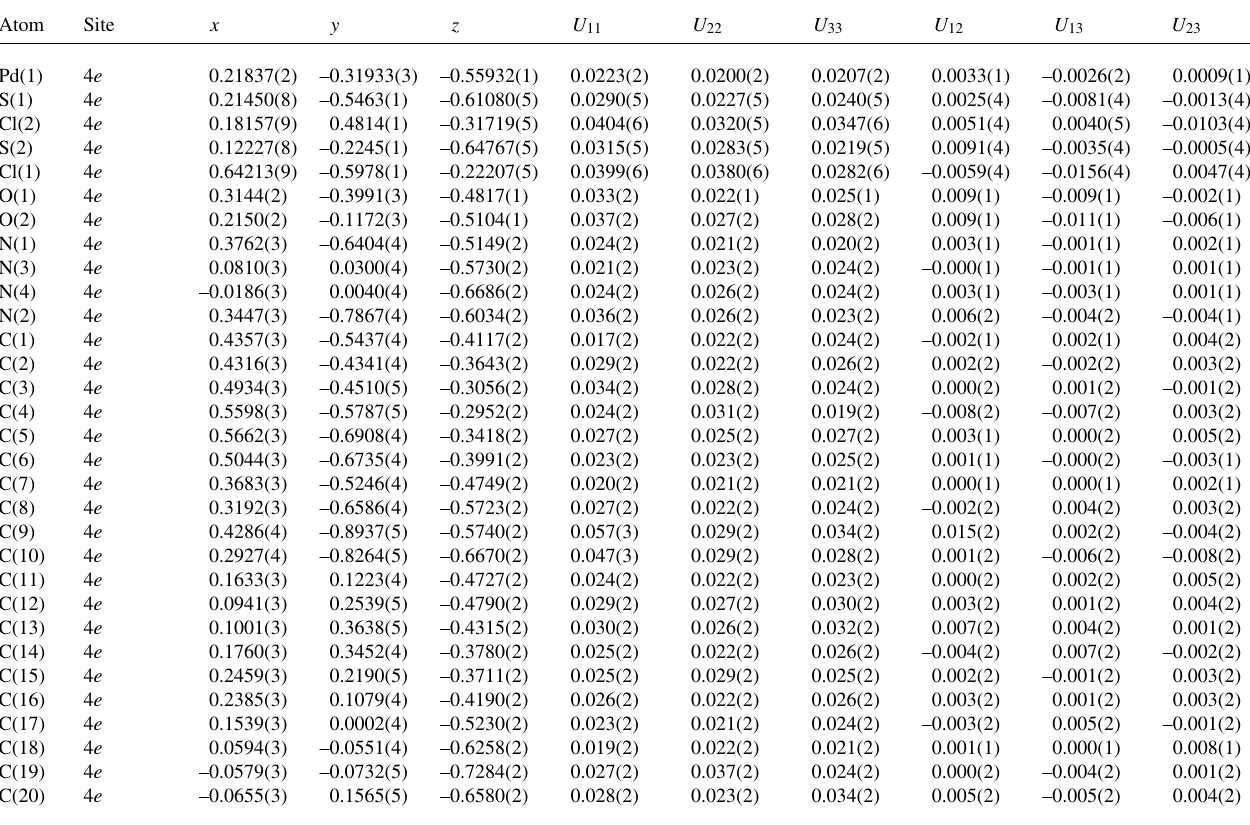
Table 3. Atomic coordinates and displacement parameters (in Å 2 )